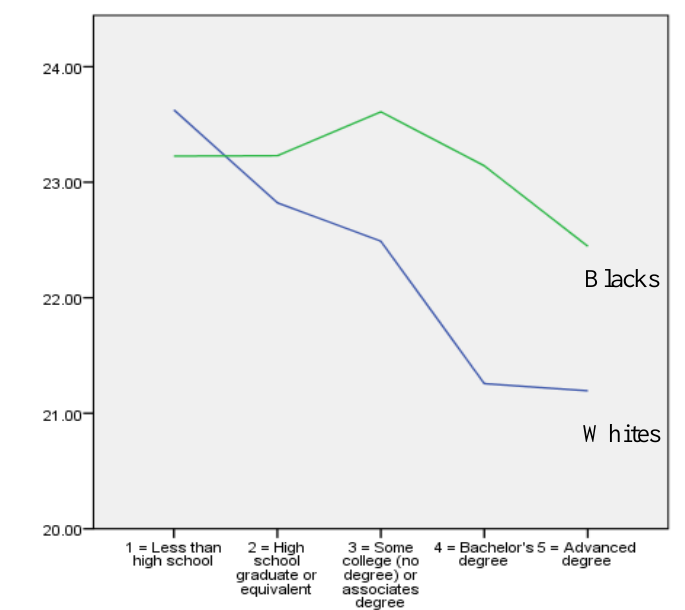
Figure 1. Average youth body mass index (BMI) based on parental educational attainment in whites ( Blue line ) and blacks ( Green line ).